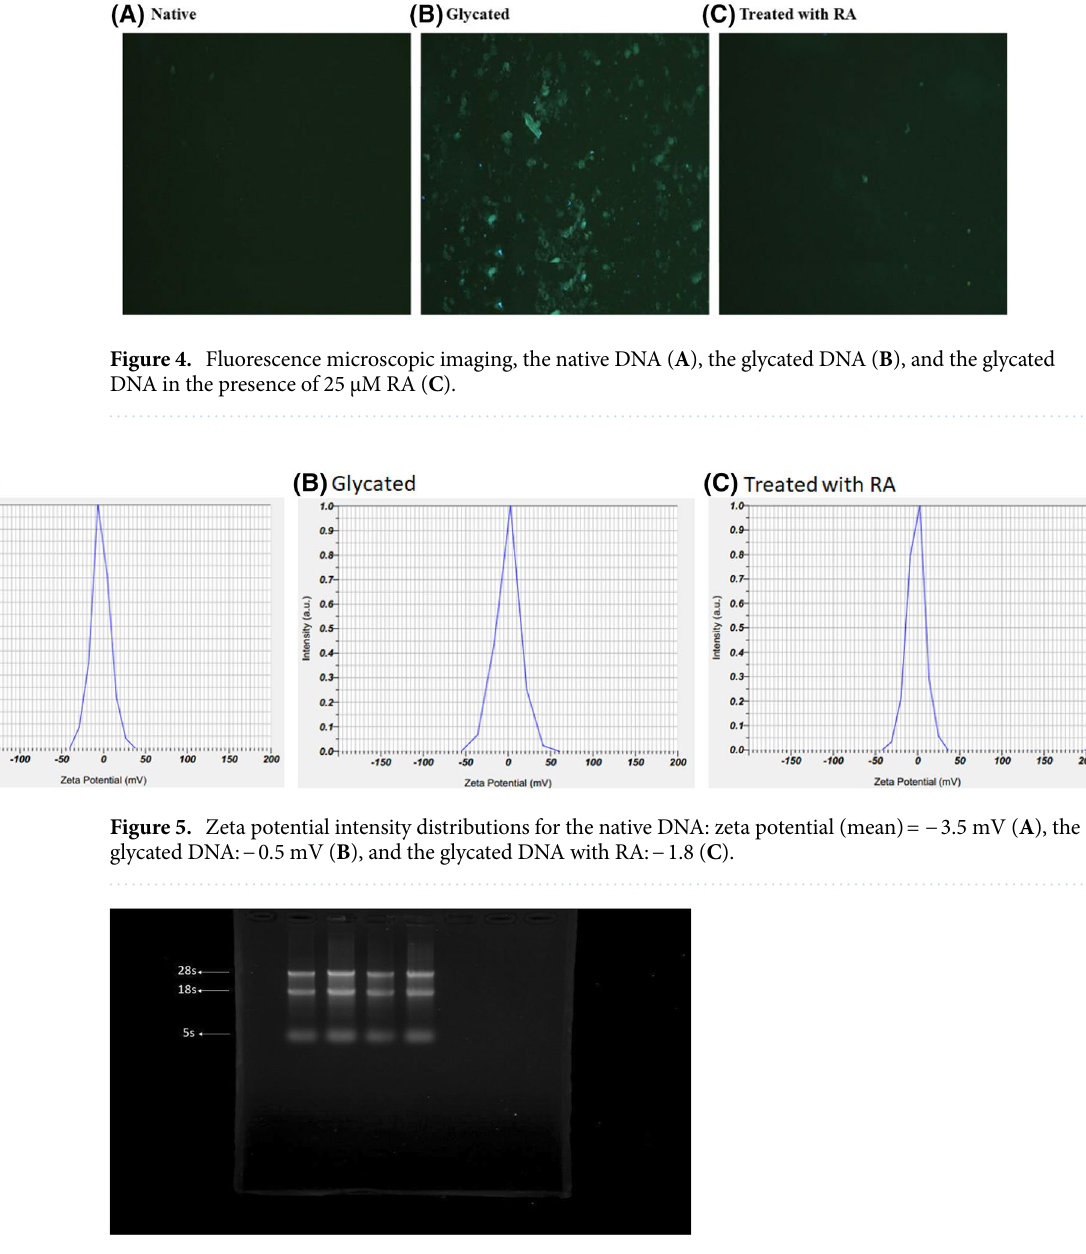
Figure 6. RNA samples isolated from hippocampus electrophoresed on a 2% agarose gel. The presence of three bands 5 s, 18 s, and 28 s are